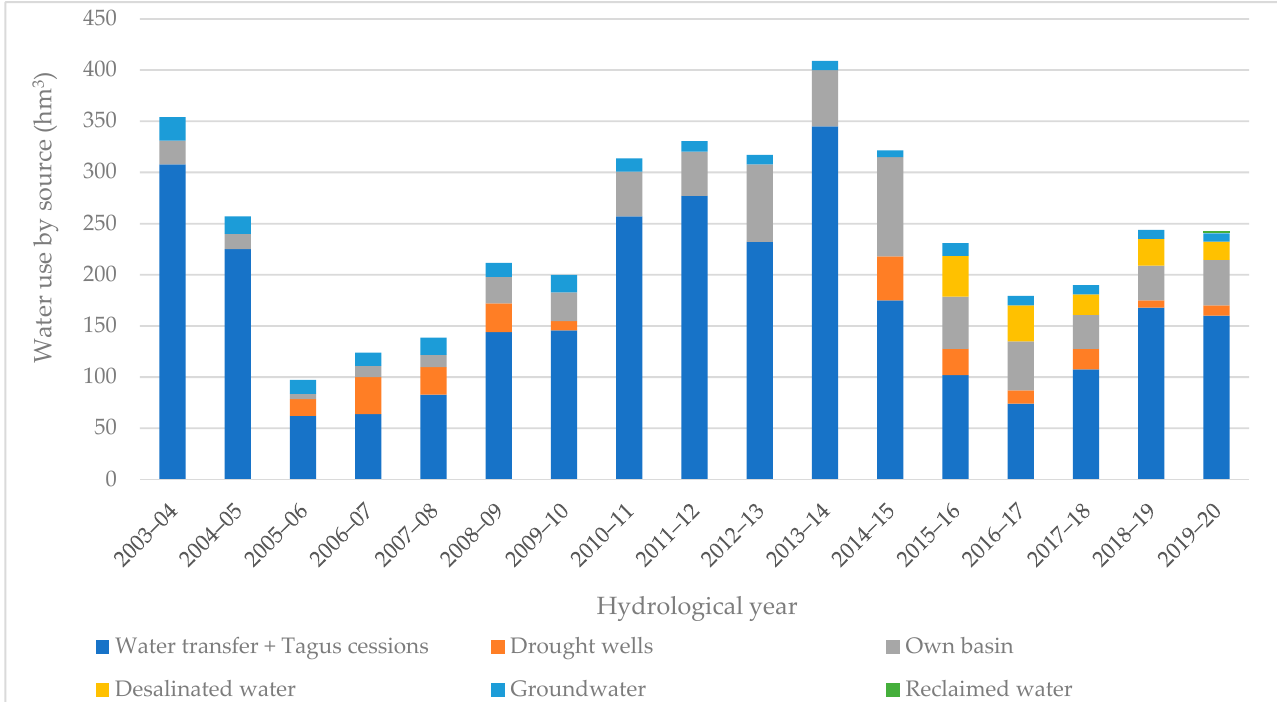
Figure 3. Comparison of water use by hydrological year (hm 3 ). Source: Approximation of [36].